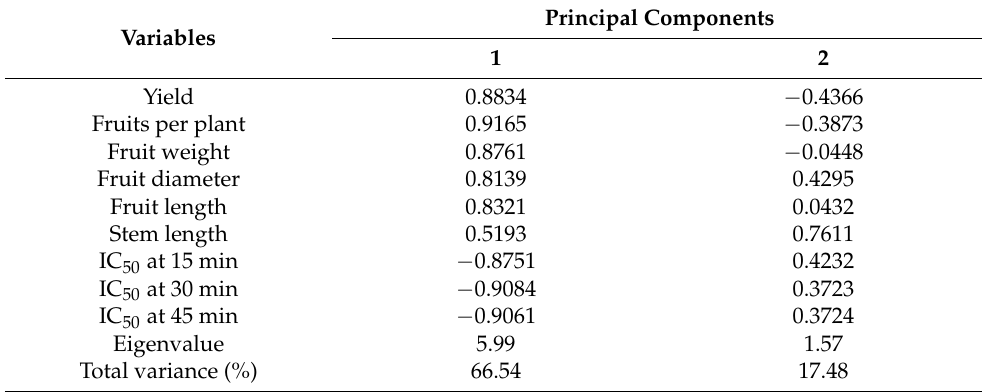
Table 3. Loadings of the significant variables on two first principal components from data